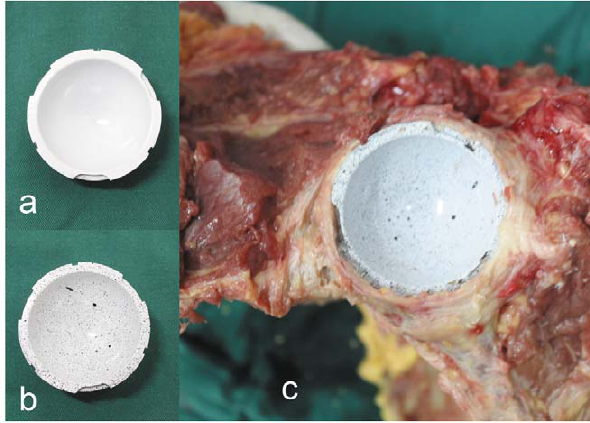
Figure 1. (a)Durom cup after white sprayed (b)Durom after black dots sprayed (c) Implantation of the Durom